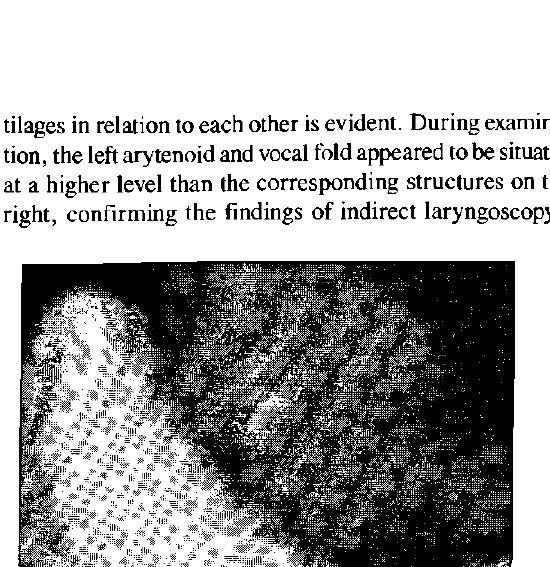
Figure 5 Fiberoptic view of M.P. 's larynx taken at rest. The tips of the arytenoids are visible in the top part of the pic- ture, one true fold and the two ventricular folds in the middle and the cushion of the epiglottis at the bottom centre.